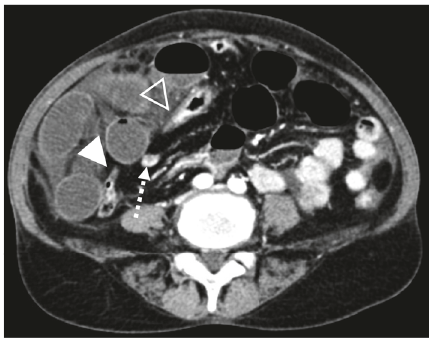
Figure 2: Axial CECT image demonstrating mucosal hyperen- hancement of the ileum at the proximal transition point related to ischemia or decompressed state (dashed arrow). Kinking of the ascending colon (closed arrowhead) and transverse colon (open arrowhead) was retrospectively felt to represent the site of the epiploic appendage